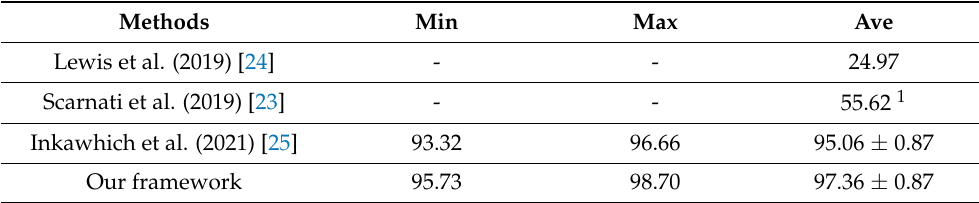
Table 10. Training Scenario II: comparisons with other methods (%).